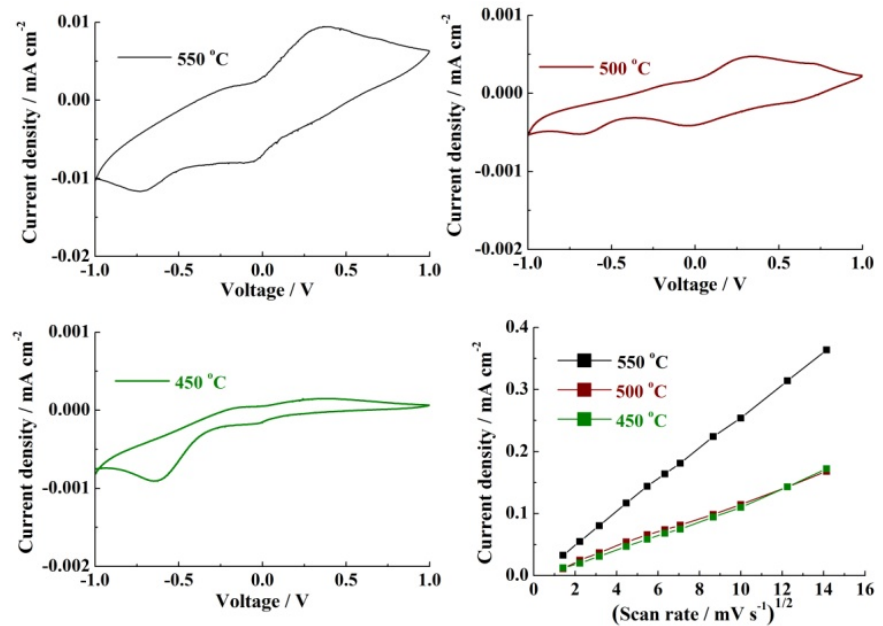
Figure 6. Cyclic voltammograms of APCVD V 2 O 5 at 450, 500, and 550 °C recorded at 10 mV ∙ s − 1 and anodic peak current density as a function of the square root of the scan rates.